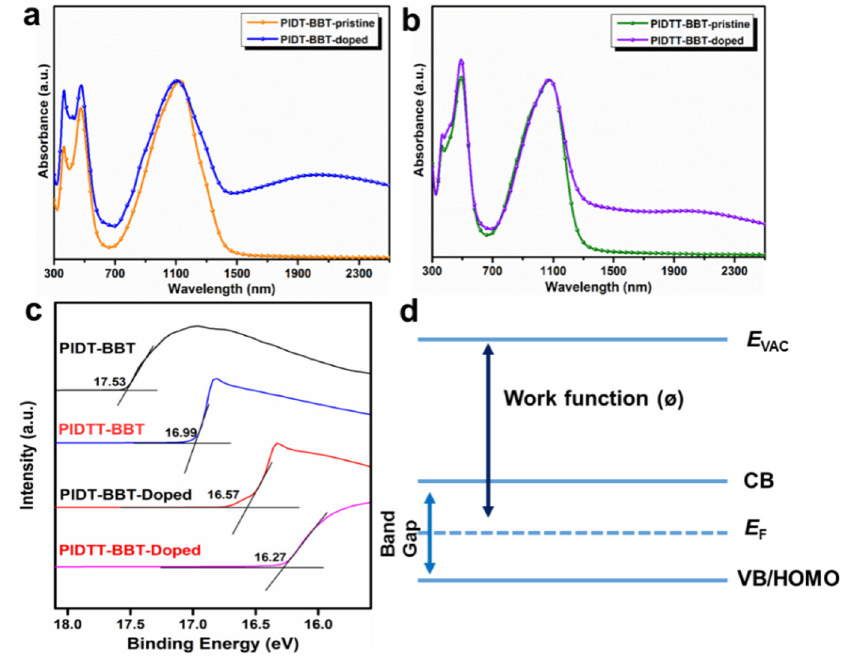
Figure 5. UV-vis-NIR absorption spectra of ( a ) PIDT-BBT and ( b ) PIDTT-BBT films after doping; ( c ) UPS spectra for the secondary electron cut-off region of polymers; ( d ) semiconductor level structure diagram.